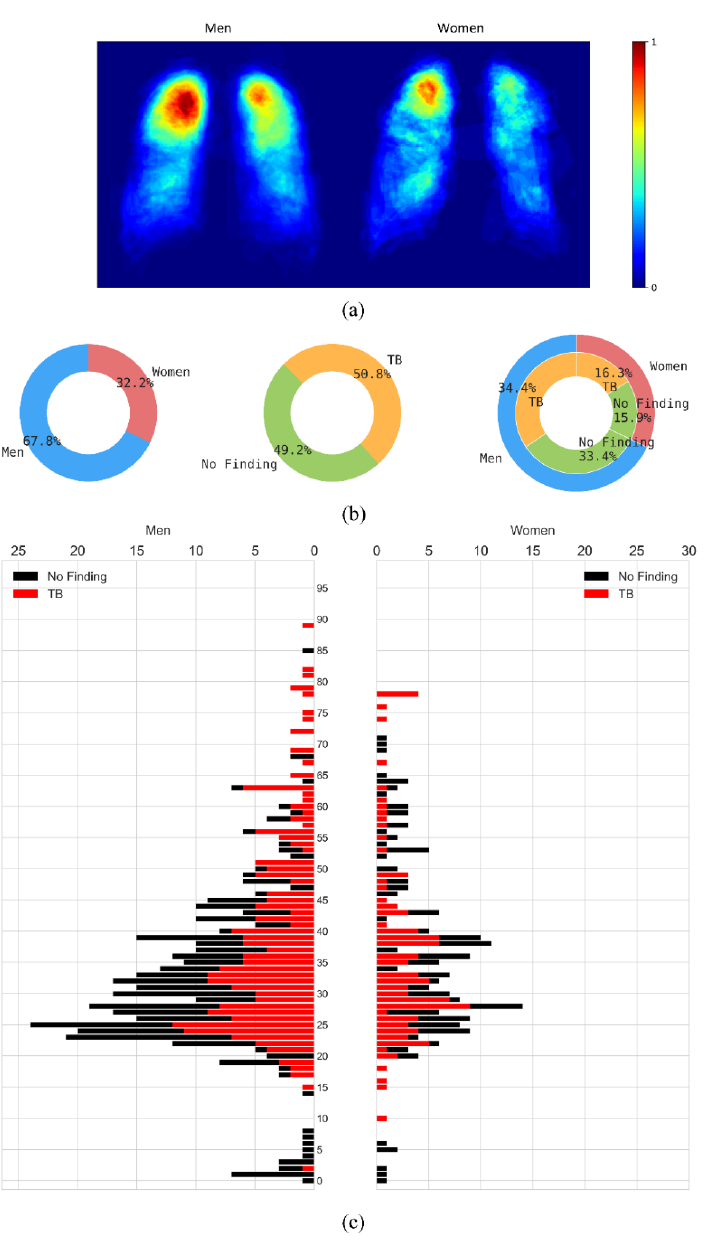
Figure 1. Data characteristics are shown as a proportion of men and women in the Shenzhen CXR collection. ( a ) Heatmaps showing regions of TB infestation in men and women. ( b ) Pie chart showing the proportion and distribution of TB in men and women, and ( c ) Age-wise distribution of the normal and TB-infected population in men and